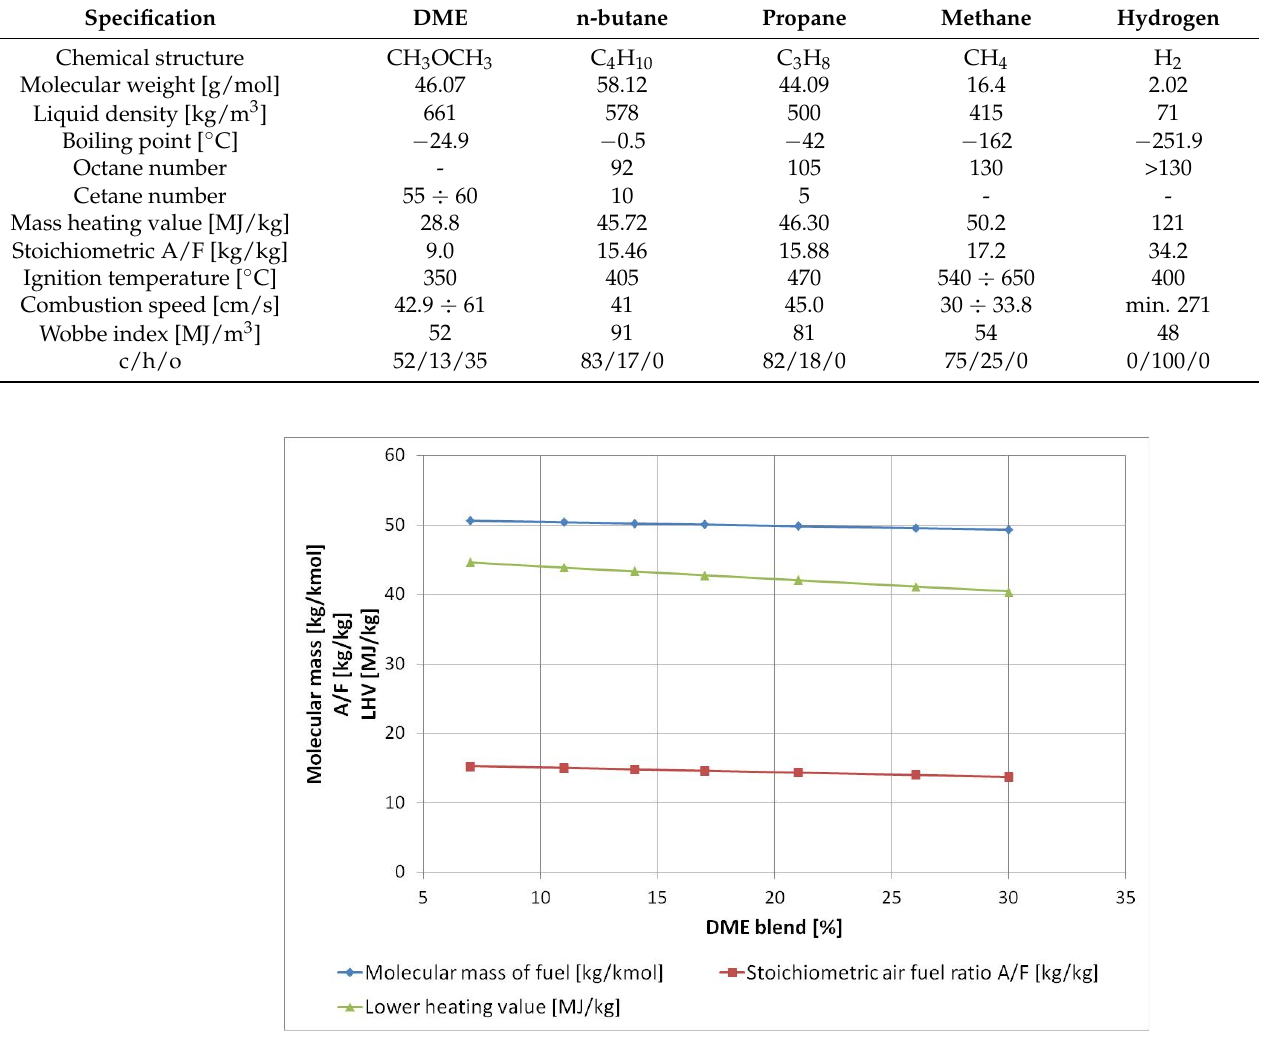
Figure 5. Stoichiometric air–fuel ratio (red line) and oxygen contents (blue line) for different LPG + DME mixtures.